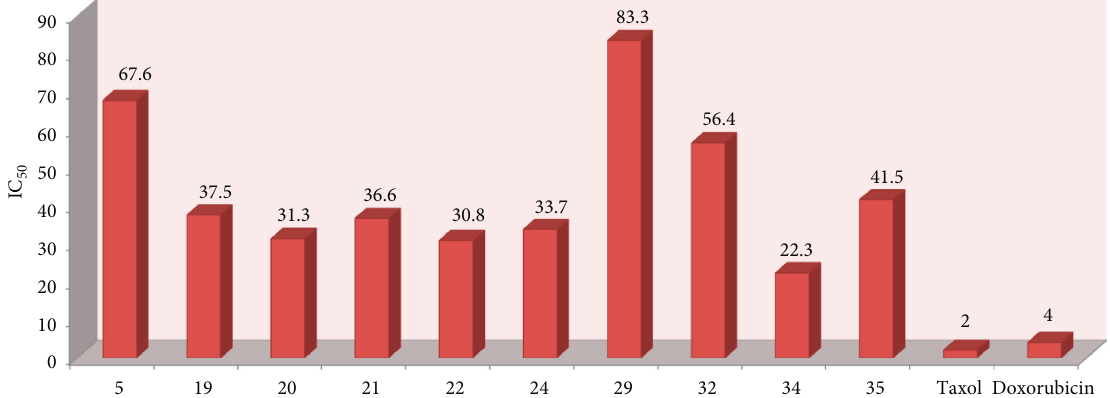
Figure 3: IC 50 [ μ M] of the active isolated compounds against leukemia K562 cell line.